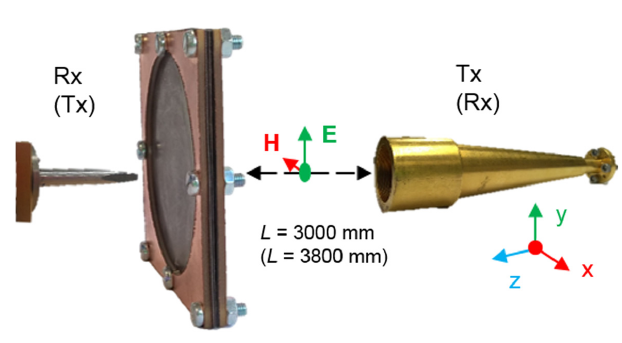
Figure 4. Scheme of experimental setup for the focal measure- ments (radiation measurements) with a waveguide probe as a receiver (transmitter) and a standard high gain horn antenna as a transmitter (receiver).